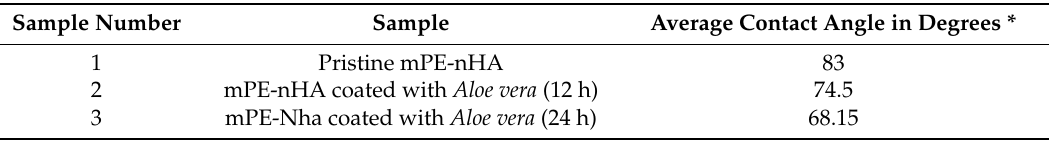
Table 1. Contact angle measurement of the mPE before and after HNO 3 treatment.